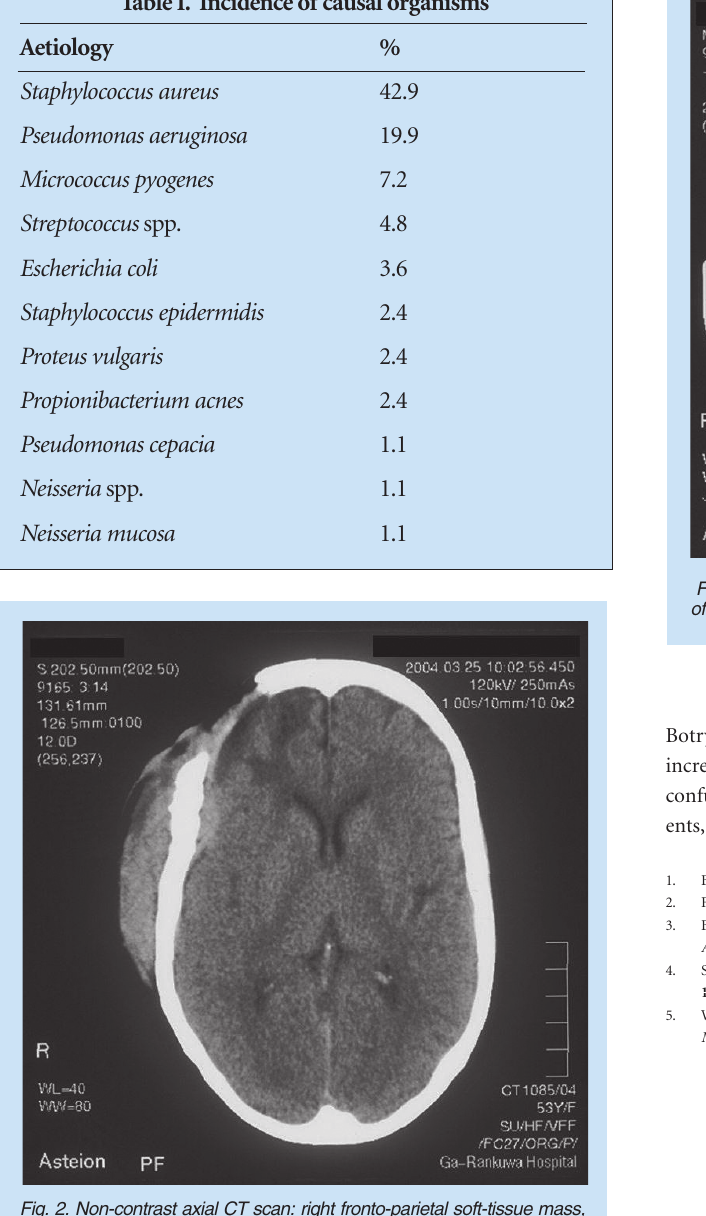
Table I. Incidence of causal organisms